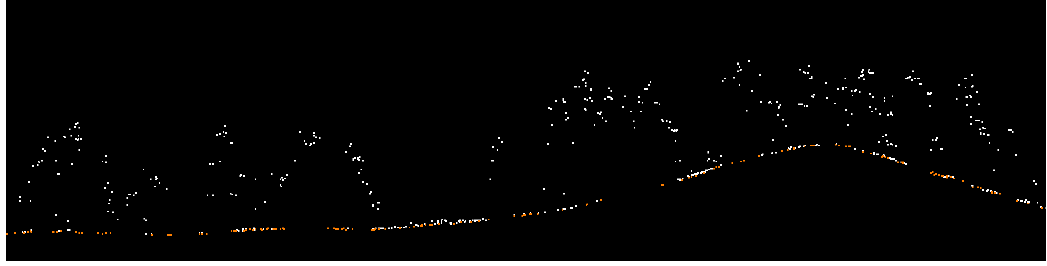
Figure 2. The profile of ground point separation results (orange ones indicate the ground points, and white ones are the non-ground point.).